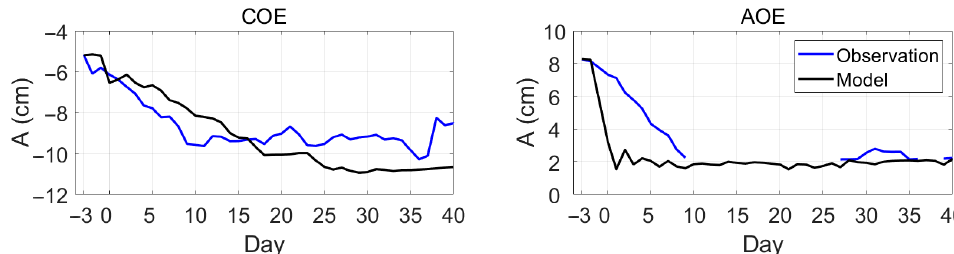
Figure 4. Time series of observed (blue) and simulated (black) amplitudes (unit: cm) of the COE and AOE in the dipole. The horizontal axis represents days after the TC. The observations and numerical results are daily data and the latter processed by 3-day smoothing. The gaps in the observational time series for the AOE represent the temporary disappearance of the AOE.